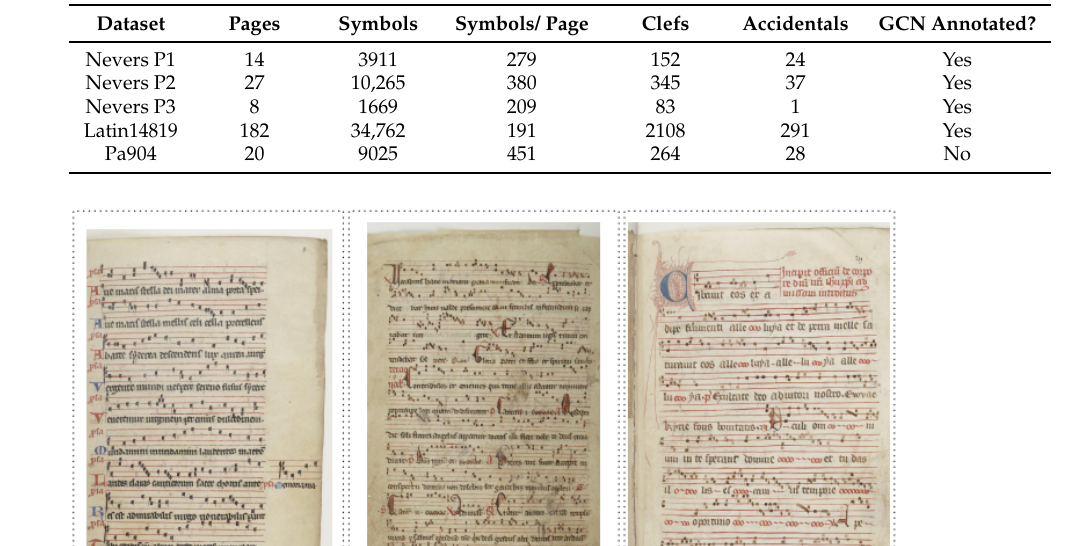
Table 1. Overview of dataset properties (Nevers P1 means Part 1). All datasets except Pa904 consist of